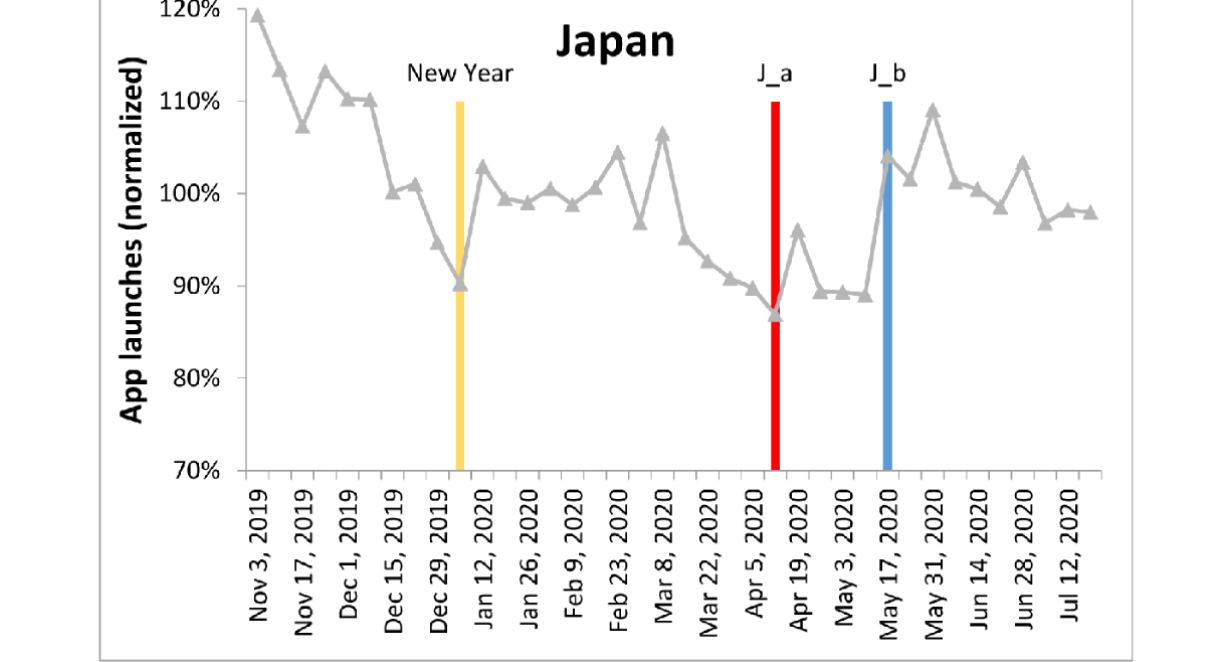
Figure 5. App launches in Japan, color-coded as in Figure 3. J_a: Japan’s prime minister proclaimed a 1-month state of emergency from April 8 to May 6, 2020, for Tokyo and the prefectures of Kanagawa, Saitama, Chiba, Osaka, Hyogo, and Fukuoka. J_b: Japan’s prime minister lifted the state of emergency imposed in 39 of 47 prefectures, announcing that the nation’s rate of infection has decreased to one-seventh of its peak.